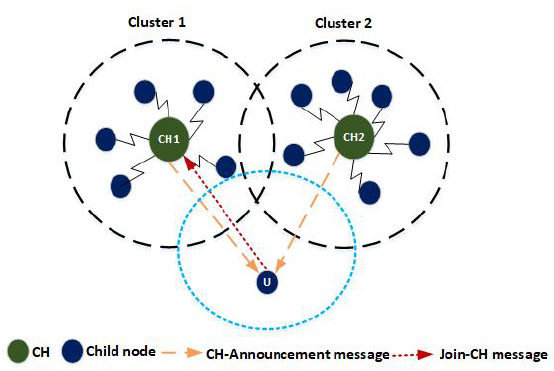
Figure 2. Nodes association